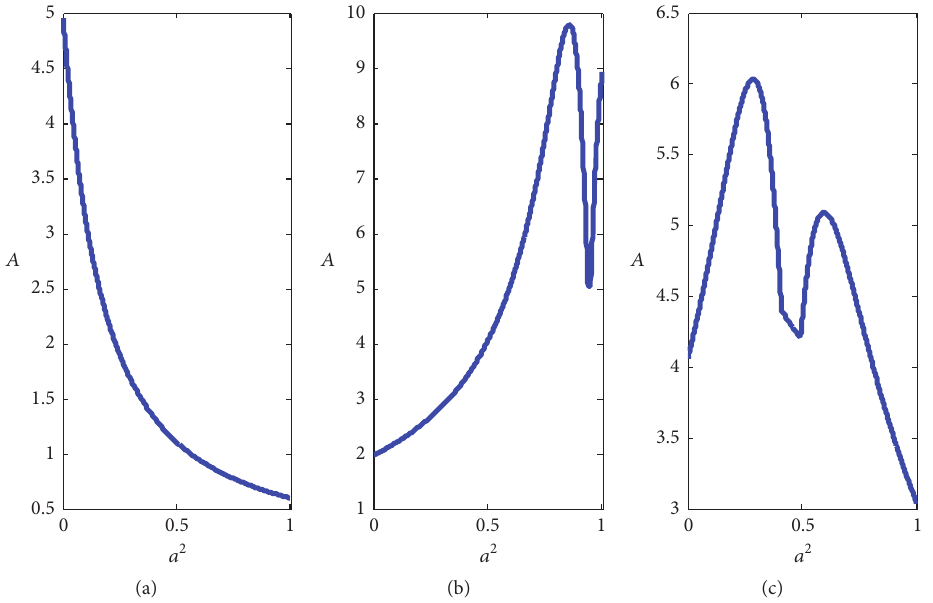
Figure 3: The output amplitude 𝐴 versus the noise intensity 𝑎 2 with various (𝐷, Ω) be chose through Figure 2, with parameters 𝜔 2 0 = 1 , = 1 , 𝐴 = 1 , V = 0.01 , 𝐻 = 0.55 , and 𝛾 = 0.3 and (a) 𝐷 = 0.3 and Ω = 0.95 ; (b) 𝐷 = 0.9 and Ω = 0.2 ; (c) 𝐷 = 1.3 and Ω = 0.6 𝐴 1 2